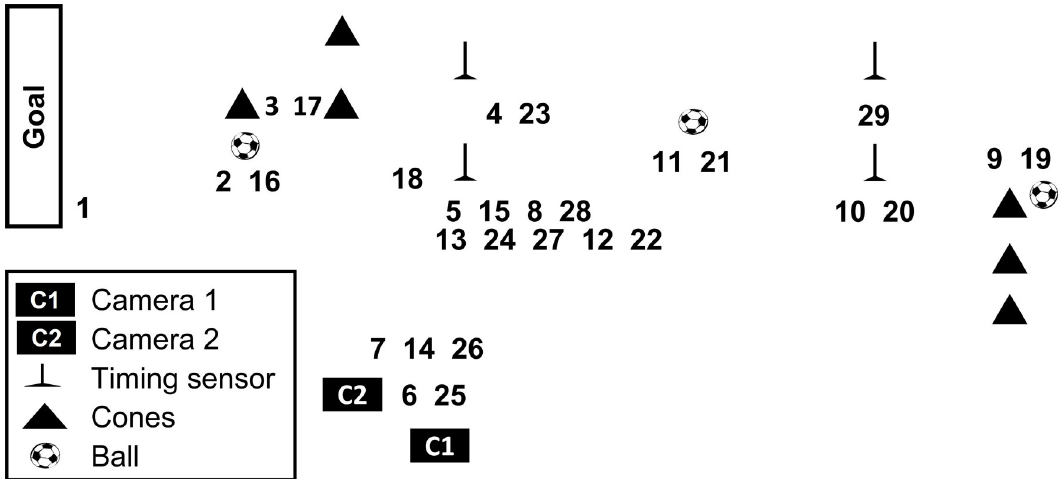
Fig 1. Football simulation protocol. This protocol was repeated three times during each time point. The protocol was to follow the numerical order as follows (1: 10-m run, 2: 10-m short pass × 2, 3: 10-m jog, 4: 40-m Arrowhead agility test, 5: 10-m run, 6: maximal vertical jump × 2, 7: 10-m side step, 8: 20-m walk, 9: 10-m dribble, 10: 10-m walk, 11: 30-m long kick × 2, 12: 10-m run, 13: 10-m back step, 14: 10-m side step, 15: 10-m jog, 16: 10-m short pass × 2, 17: 10-m jog, 18: 20-m sprint, 19: 10-m dribble, 20: walk, 21: 30-m long kick × 2, 22: 10-mjog, 23: 40-m Arrowhead agility test, 24: 10-m back step, 25: maximal vertical jump × 2, 26: 10-m side step, 27: jog, 28: 10-m walk, 29: 20-m